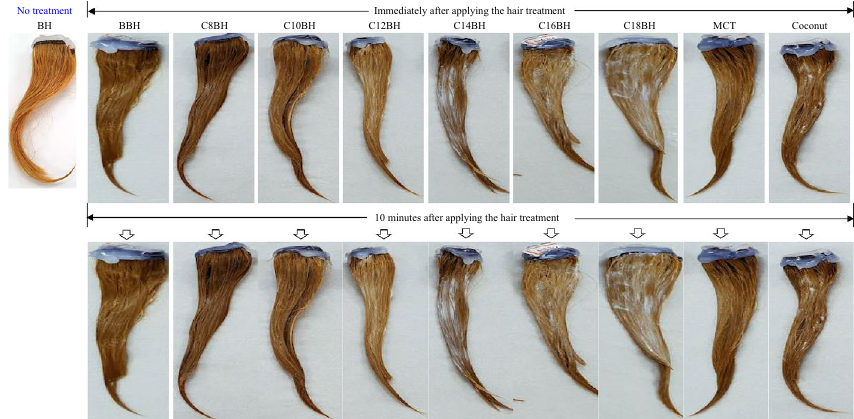
Fig. 1 Appearance of bleached hair (BH) after the application of hair treatments. BH was untreated (0-day) and the photos of BBH–Coconut were taken during the 21th day of